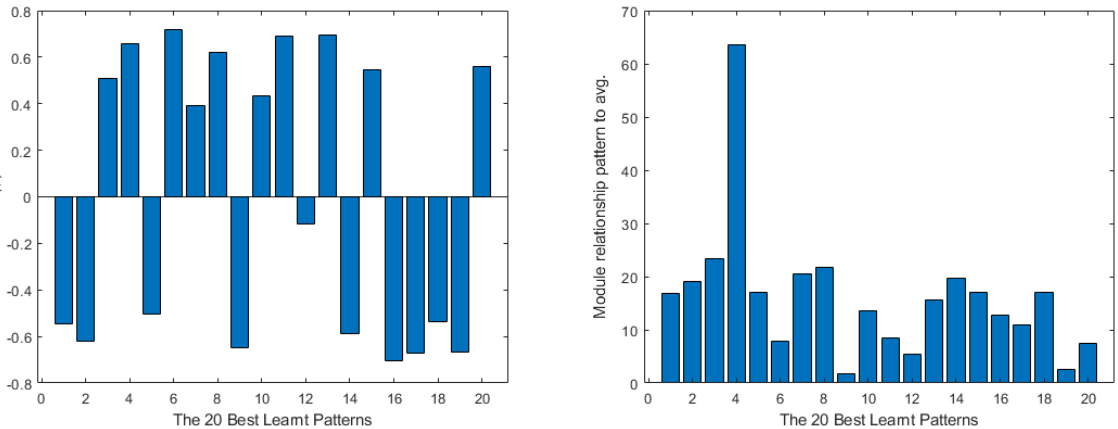
(cid:12) (cid:12) 𝜕𝐿𝑜𝑠𝑠 ∂ Loss (cid:12) (cid:12) | relationship to the average (cid:12) (cid:12) relationship to the average ∂ W n 𝜕𝑊 𝑛